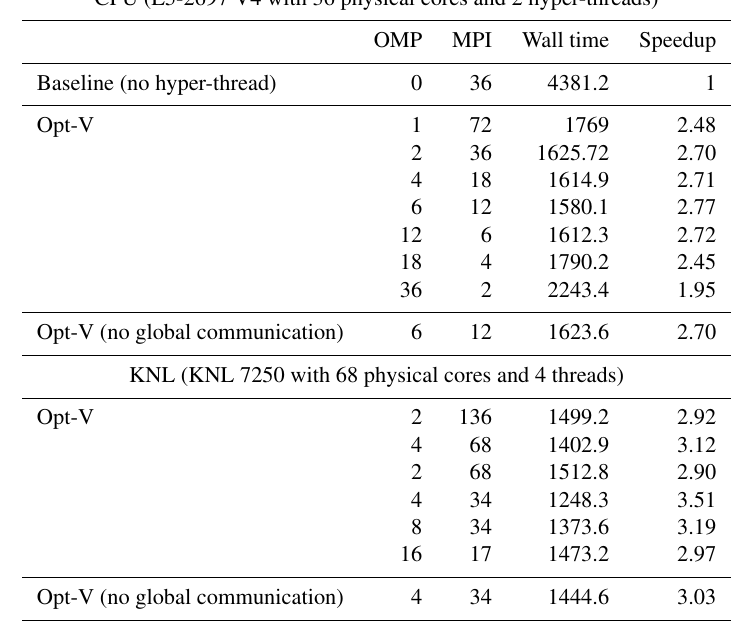
Table 4. Speedup and wall time of different combinations of OpenMP threads and MPI processes. CPU (E5-2697 V4 with 36 physical cores and 2 hyper-threads) OMP MPI Wall time